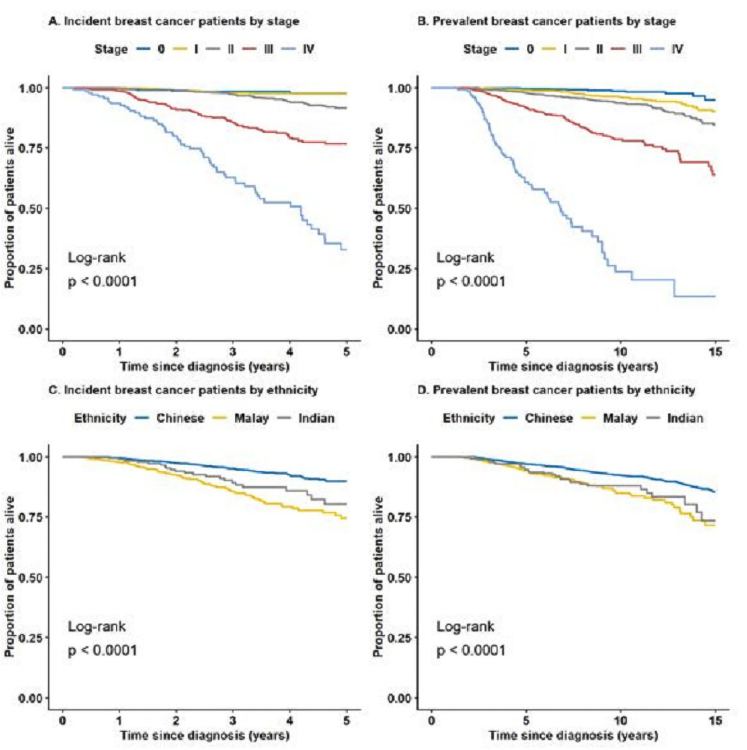
Fig 3. Overall survival of breast cancer patients by stratified case type (incident, prevalent) and stage at diagnosis (A and B), or ethnicity (C and D).